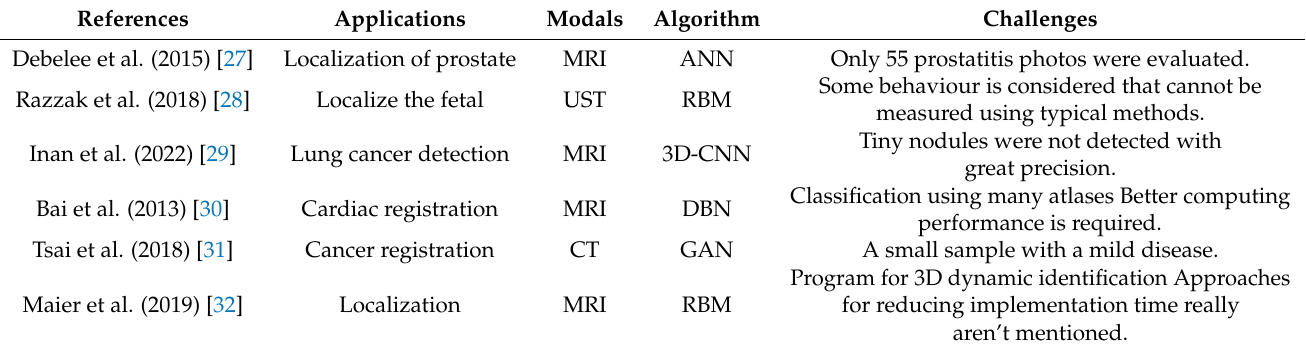
Table 3. Segmentation tasks in kidney